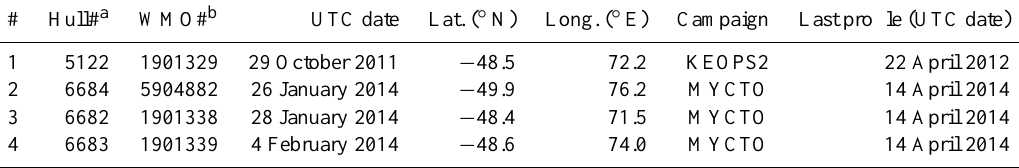
Table 1. Bio-profiler